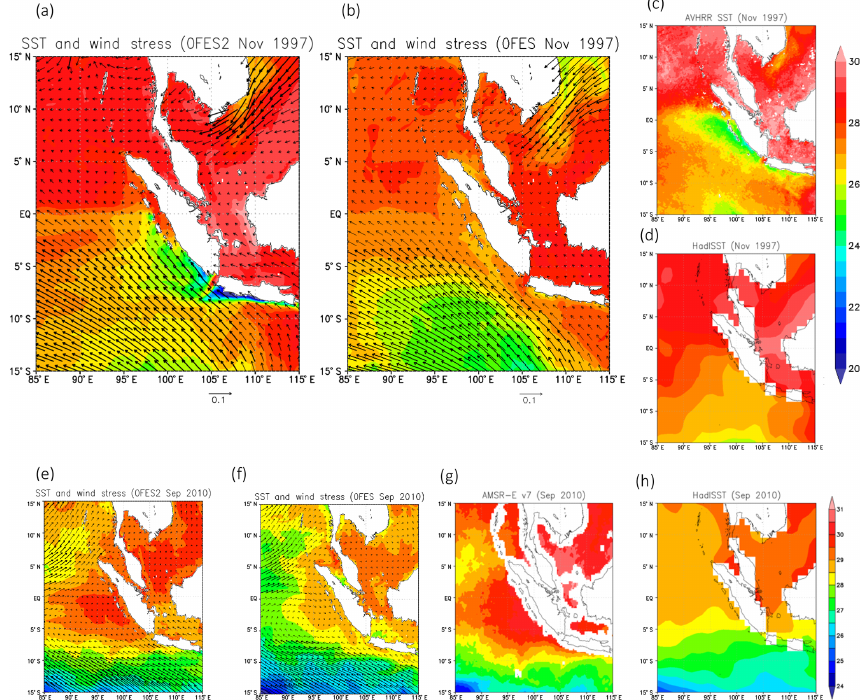
Figure 11. SST ( ◦ C) in a region including the IOD eastern pole (90–110 ◦ E and 10 ◦ S–0 ◦ ) in the mature month of (a–d) the 1997 positive IOD event (November 1997) and (e–h) the 2010 negative IOD event (September 2010). (a, e) OFES2, (b, f) OFES, (c, g) satellite observations of AVHRR version 4.1 (Casey et al., 2010) and AMSR-E version 7 (Wentz and Meissner, 2007), and (d, h) HadISST v1 (Rayner et al., 2003). The vectors in (a, b, e, f) are the surface wind stress (Nm − 2 ) in the models, which are plotted at a 1 ◦ × 1 ◦ resolution. The thick vectors denote wind stress magnitudes stronger than 0.05Nm − 2 .